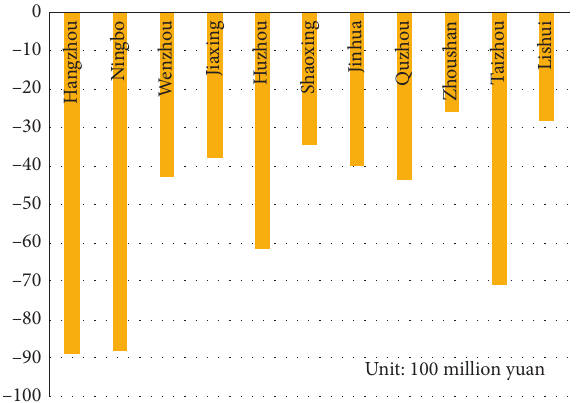
Figure 1: Comparison of structural shift component of primary